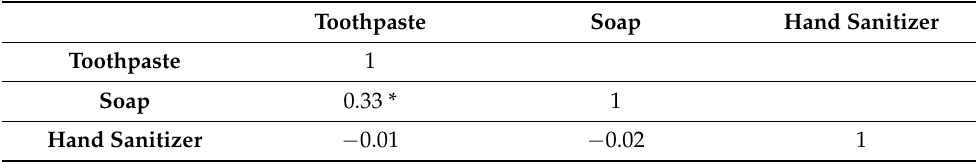
Table 8. Pairwise correlation matrix for the size of the first search result. Soap is Method body wash. * p < 0.01.